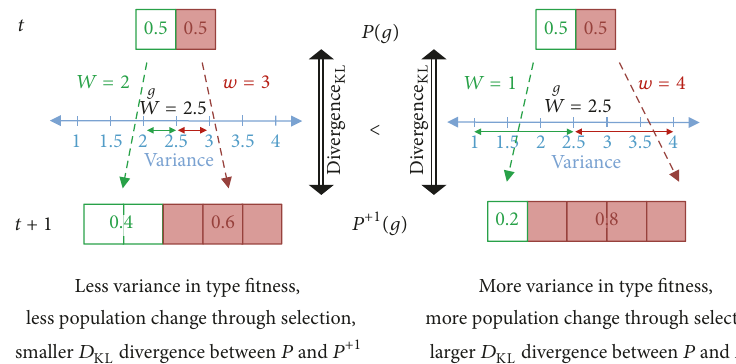
Figure 2: Illustration of Kullback-Leibler relative entropy as a measure of strength of evolutionary selection. The left hand side illustrates a case with less variance in type fitness, less population change through selection, and smaller 𝐷 (0.4; 0.6). The right-hand side illustrates the case with larger variance in type fitness, more population change through selection, and larger 𝐷 divergence between 𝑃 (0.5; 0.5) and 𝑃 +1 (0.2; KL